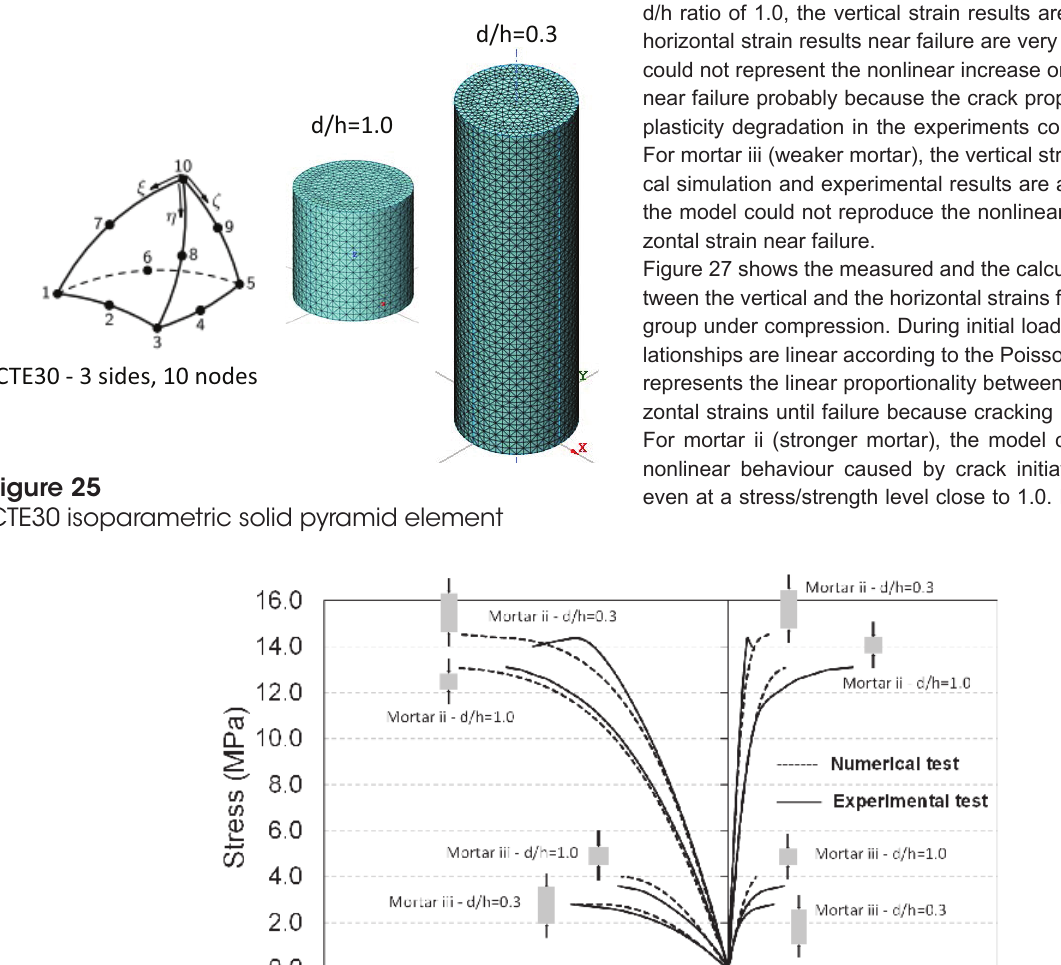
Numerical and experimental stress-strain